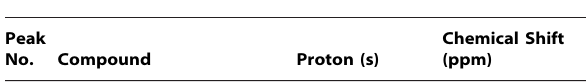
Table 2. Peak assignment for iMQC spectrum of shishamo smelt eggs.